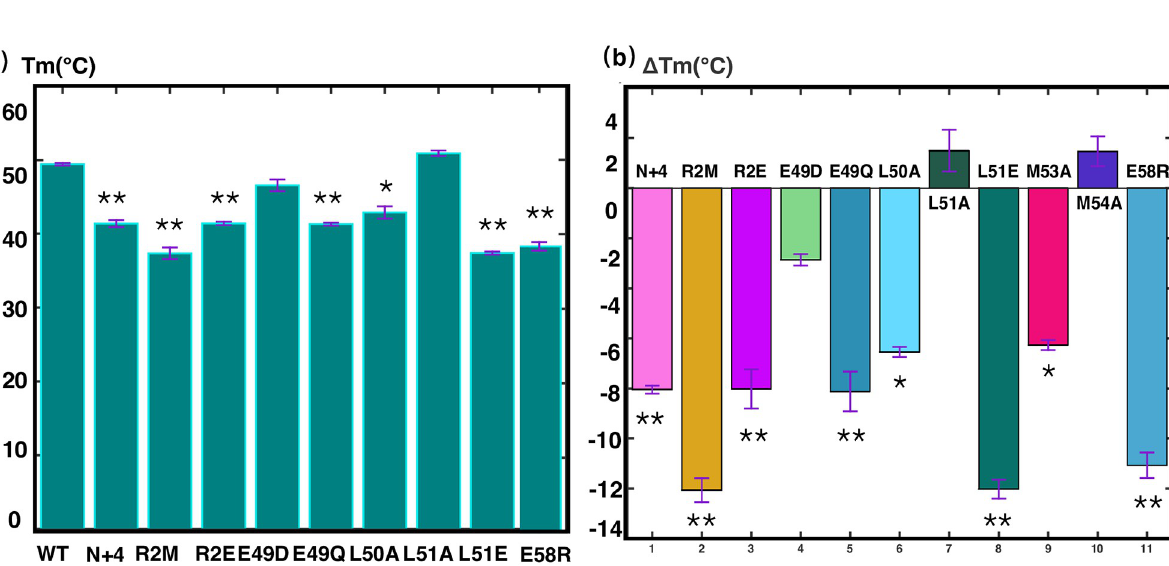
Fig 7. Fluorescence thermal shift assay of PRC1-DD and its mutants (bar graph representation of data in Table 2). (a) Bar graph showing the mid- denaturation temperature (Tm) of wild-type PRC1-DD and its mutants. The name of each mutant is labeled on the x-axis of the figure, R2M refers to Δ 1R2M. (b) Changes in Tm ( Δ Tm) of mutants compared with wild type. The respective mutants’s colors are as labeled. Graphs were produced in MATLAB, plotted from the mean and standard deviations (thin red T) of Tm from four parallel experiments; single star indicates statistical significance (p < 0.05) and double star indicates strong significance (p <